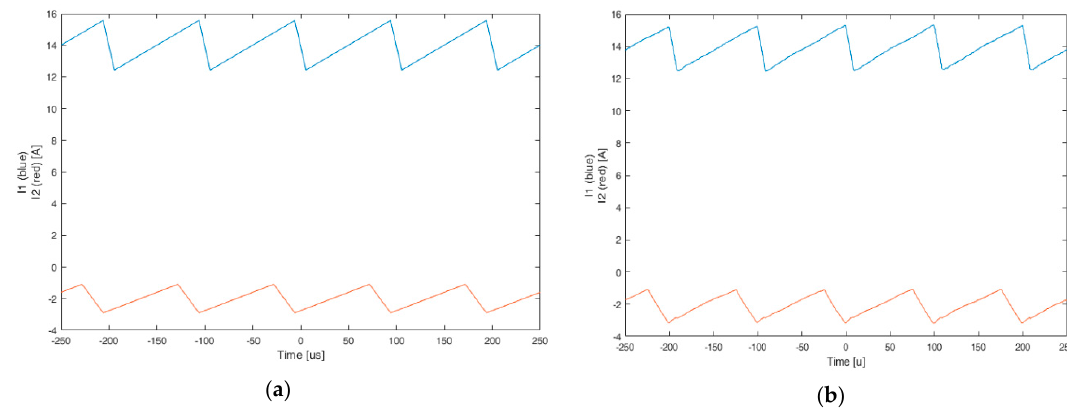
Figure 13. Current waveforms in Test 2 ( a ) simulation ( b ) experimental.